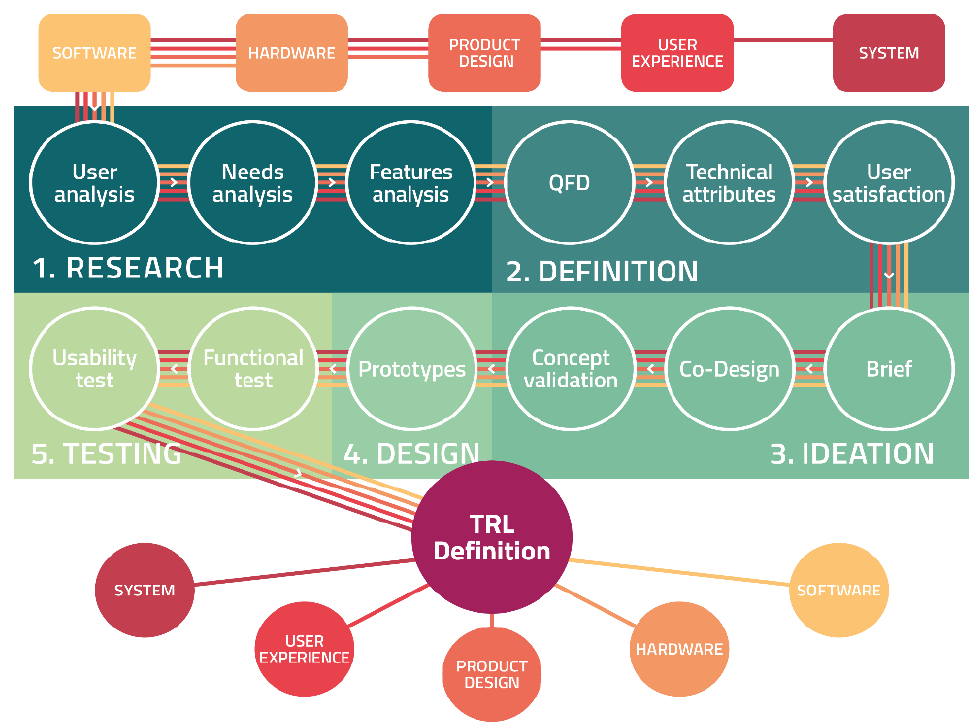
Figure 2. Process flow scheme adopted for the methodological User-Centered Design process. TRL: Technology Readiness Level; QFD: Quality Function Deployment.